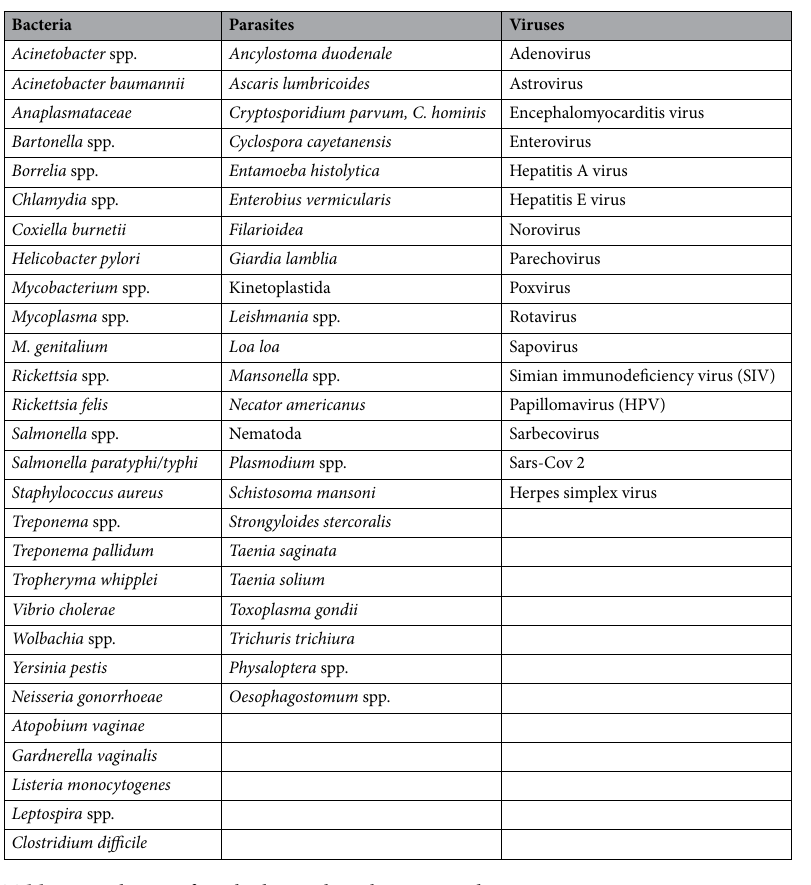
Table 3. Pathogens for which tests have been carried